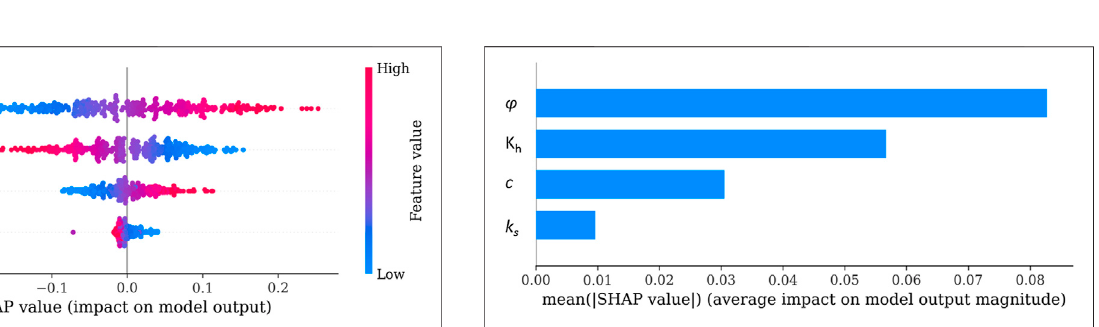
scattered point on the fi gure represents one sample, and the points with red colors indicate that the associated feature values are high. On the other hand, the blue colors imply that the feature